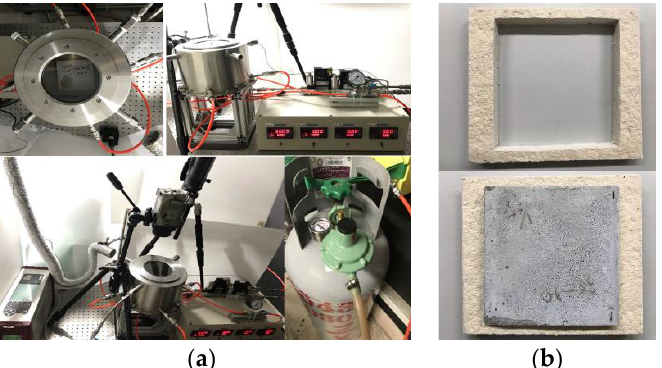
Figure 2. Miniaturized fire-retardant material test furnace system and specimens fixing frame. ( a ) System assembling. ( b ) The fixing patterns of specimens. ( a ) System assembling. ( b ) The fixing patterns of